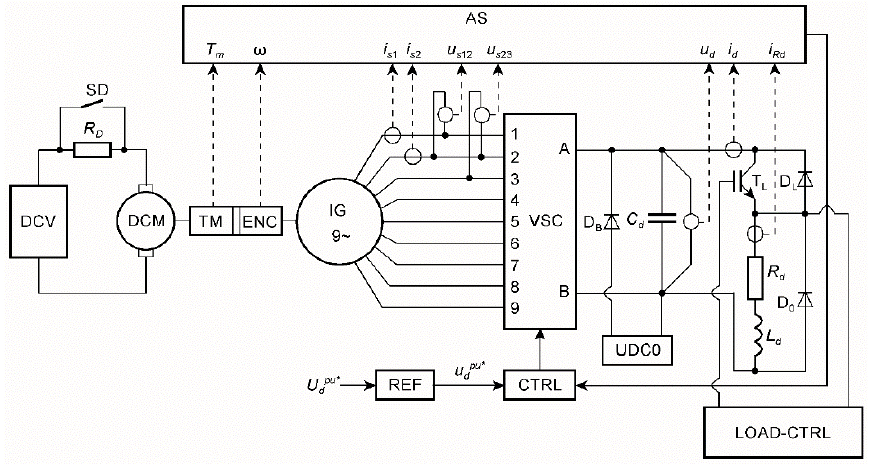
Figure 11. Structure of the test bench: DCV — DC voltage supply, R D — additional resistance, DCM — DC motor driving the induction generator IG, TM — torque meter, ENC — encoder, N — star point of stator phase windings, AS — acquisition and measurement system, LOAD (T L , R d = 8.5 Ω , L d = 15 mH, D 0 ), C d = 4400 μ F, DCV — controlled DC voltage supply, R D — additional resistance shorted by means of SD.